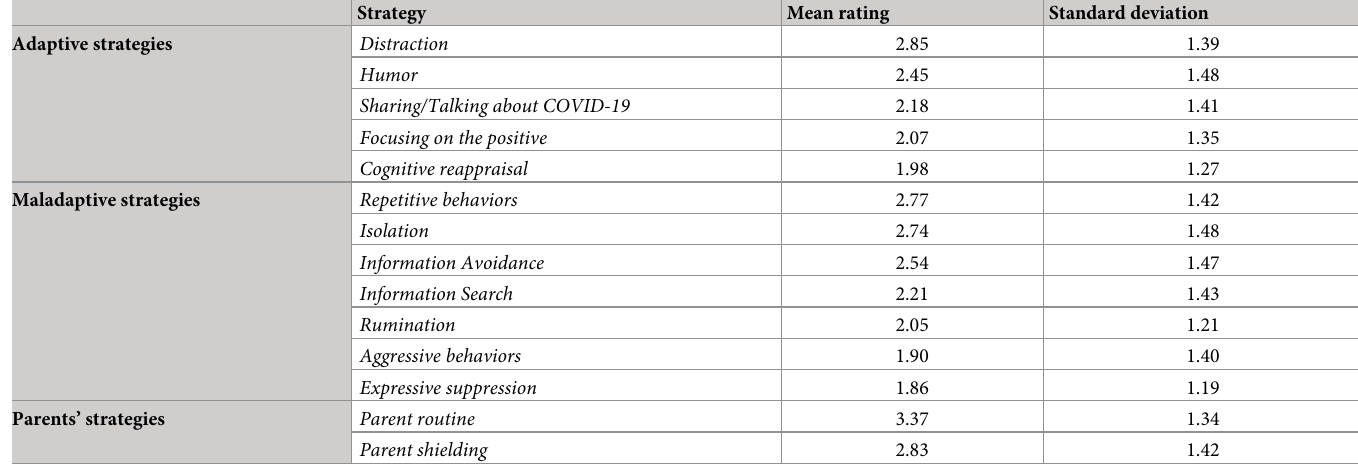
Repeated measures ANOVAs with Greenhouse-Geisser correction indicated that the mean ratings of frequency were significantly different across the coping strategies (F(9.477,957.142) = 25.539, p < .001, η p2 = .20) and showed interactions between coping and child age groups (F (18.953,957.142) = 1.784,(p = .021, η p2 = .03). Table 4. Descriptive statistics of the efficacy of coping strategies (n =